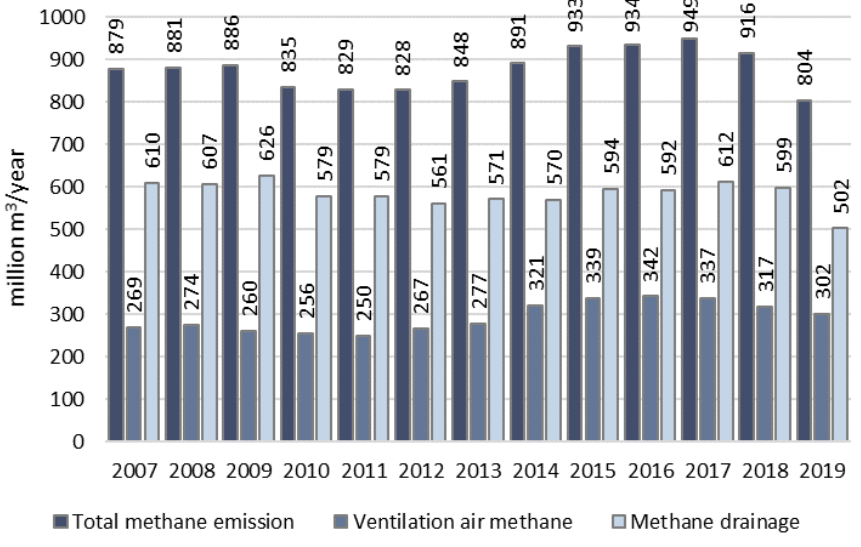
Figure 1. Methane emissions into the atmosphere—total, with ventilation air (VAM) and captured by